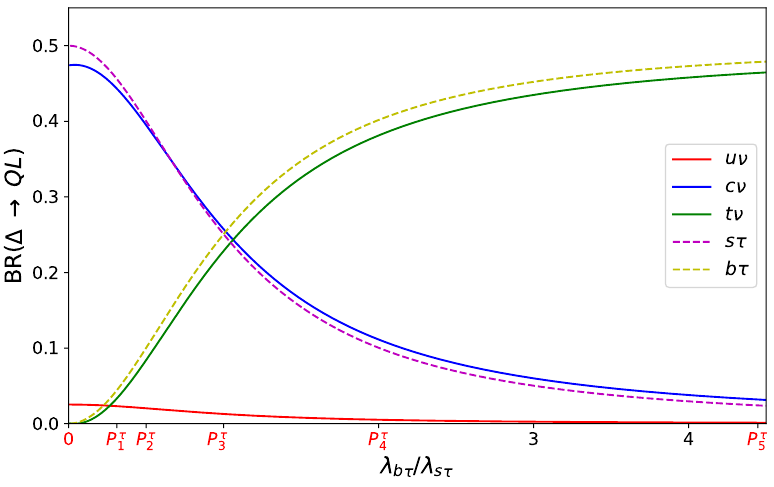
Figure 3 . 2 TeV LQ branching ratios into quarks and leptons for the τ − isolation pattern. The channel magnitudes only depend on the ratio of the couplings. The non-vanishing u − ν contribution appears due to CKM rotations from λ d‘ → λ uν . The other channels are (almost) exactly vanishing in the context of the τ − isolation pattern. We have highlighted in red the position of the different benchmark points shown in figure 2. Note that P τ 2, respectively.